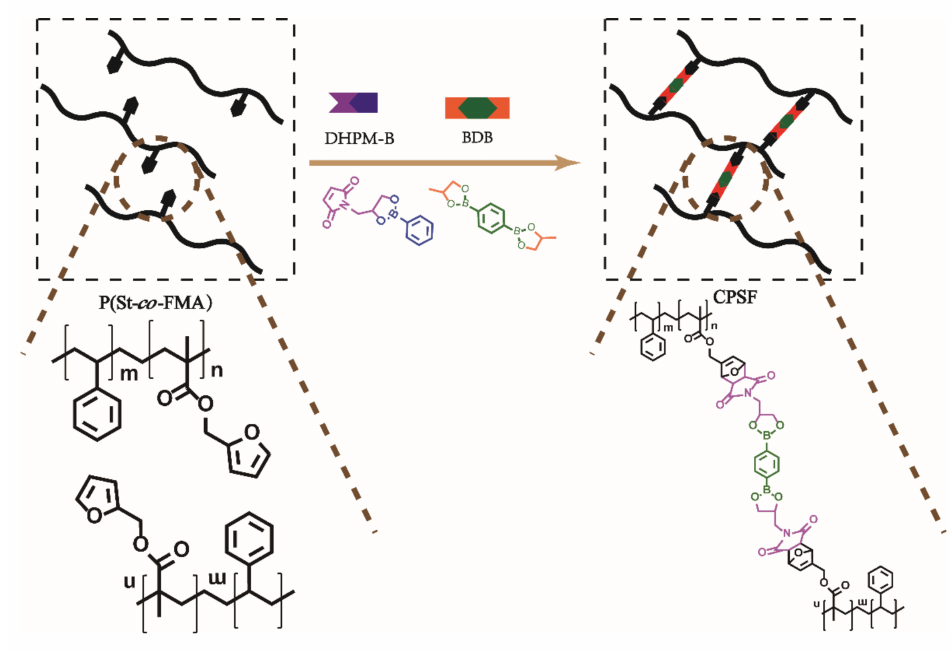
Figure 1. Preparation of CPSF CANs.